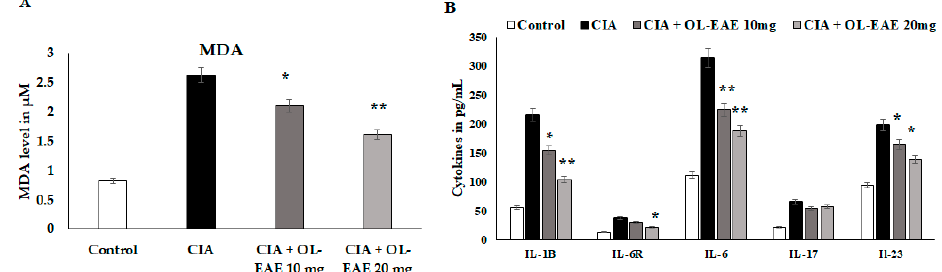
Figure 5. Estimation of oxidative stress marker malondialdehyde and inflammatory cytokines in tissue lysates using ELISA kits and methods. ( A ) The biochemical markers related to inflammation and infiltration were recorded in the CIA mice. The MDA level was expressed in µ M/mg of protein. ( B ) IL-1 β , IL-6R, IL-6, IL-17, and IL-23 in the tissue of vehicle-control mice and CIA mice after receiving repeated concentrations of OL -EAE 10 and 20 mg/100 g mouse weight for 28 days. Samples from groups comprising five mice were analyzed. Quantitative data (mean ± SD) are presented using the average optical density values at 450 nm in a microplate reader; * p < 0.05 and ** p < 0.001 significance was used to compare CIA mice to CIA/ OL -EAE-treated mice ( n =